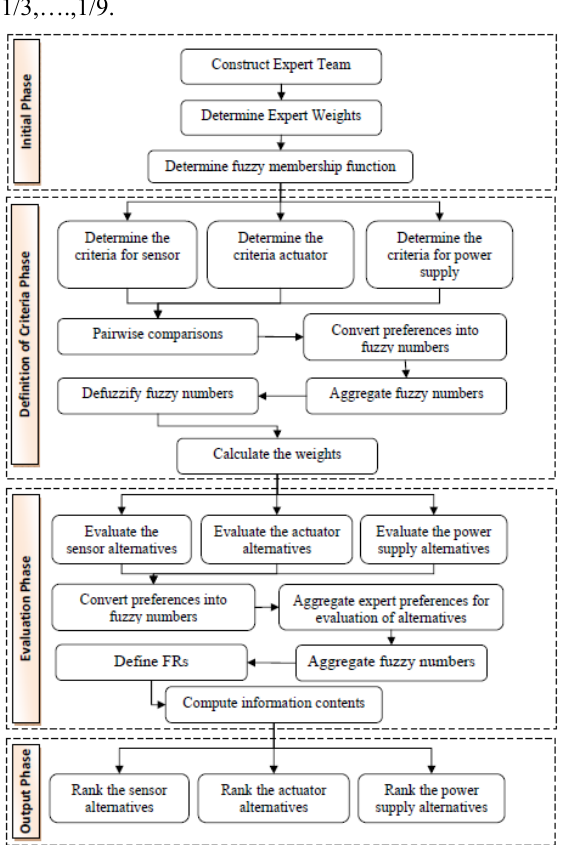
Fig. 2. Framework of the evaluation model